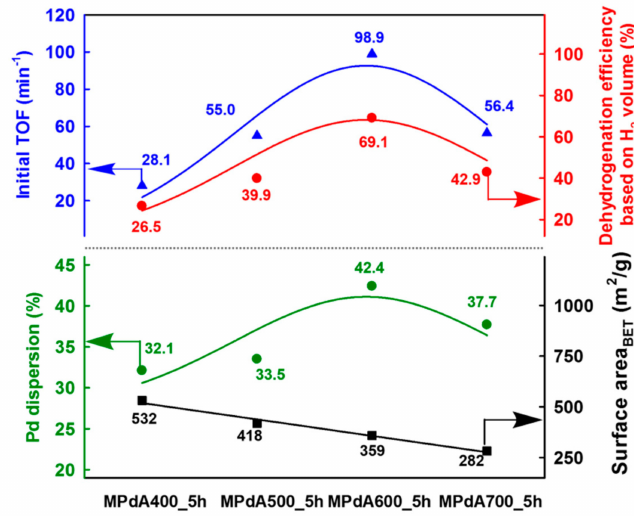
Figure 4. ( a ) Activity results obtained through the GC; ( b ) time-dependent H 2 release curves of the MPdA catalysts calcined at di ff erent temperatures for 5 h in the dehydrogenation of H 12 -MBP at M / R ratio of 0.1 mol% and 250 ◦ C for 4 h.